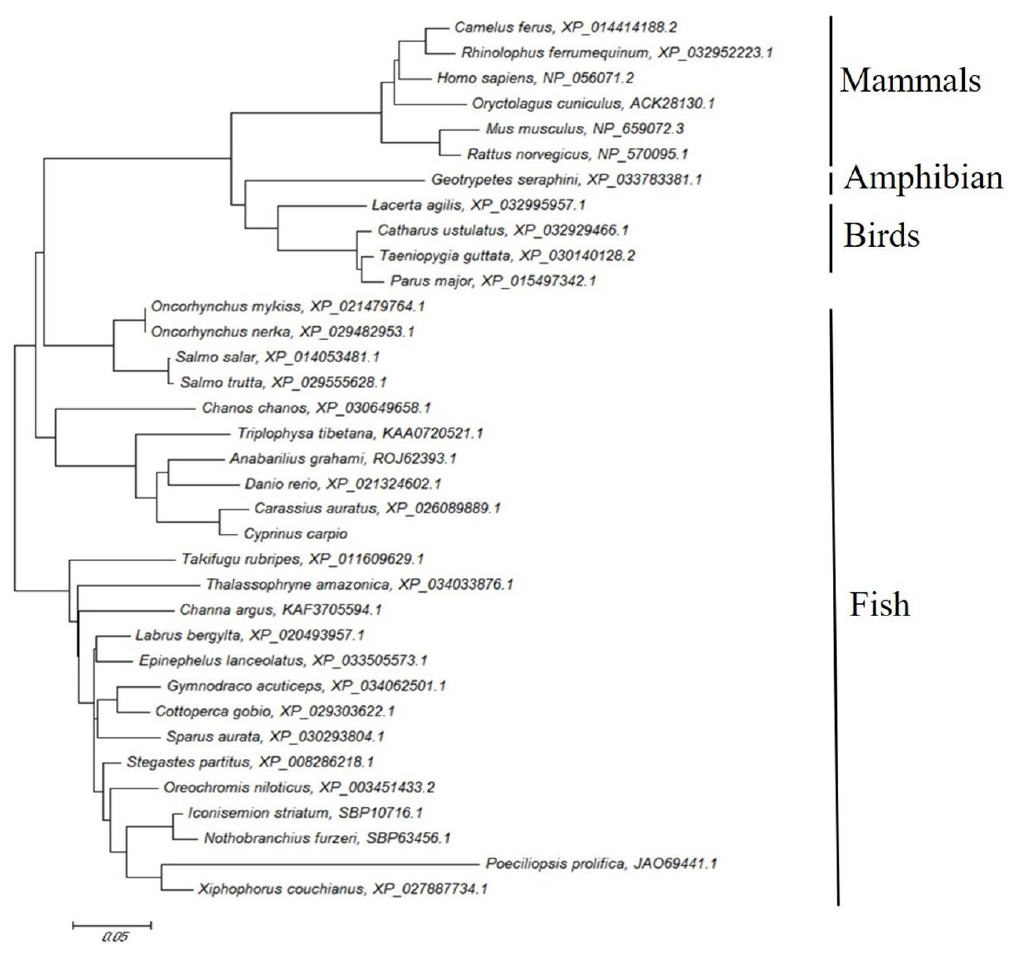
Figure 2. Phylogenetic analysis of acsl6 from different animal species: The tree is based on an alignment corresponding to full-length amino acid sequences using ClustalW and MEGA (5.0). The number denote the bootstrap majority consensus values from 1000 replicates.